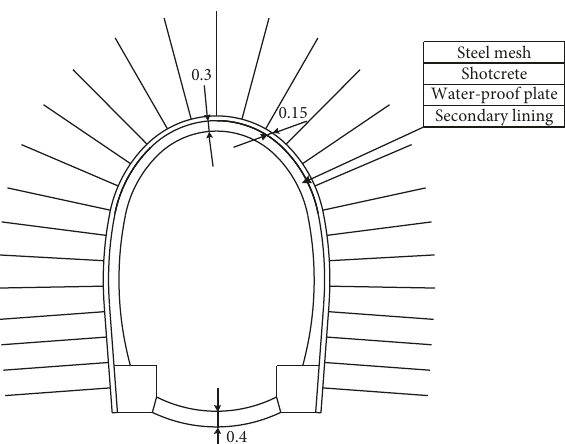
Figure 2: Typical supporting type of the tunnel (unit: